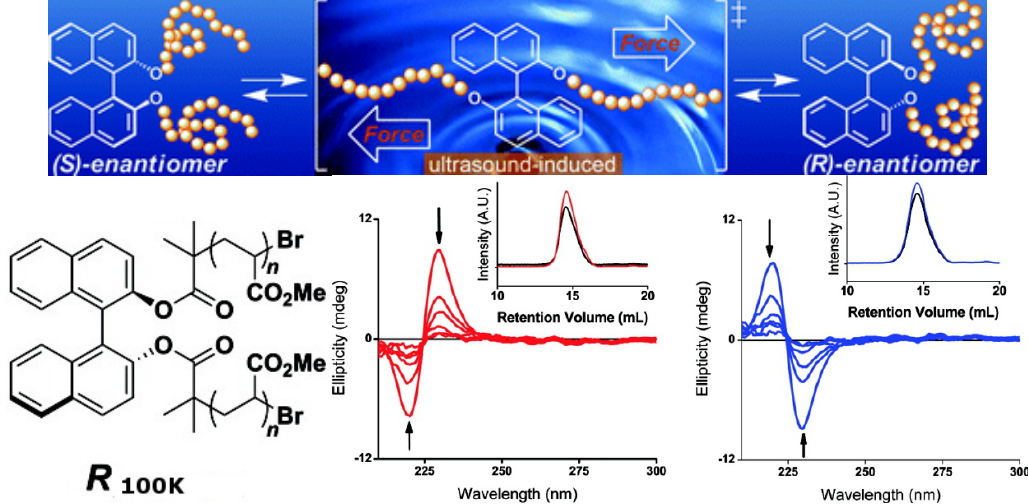
Figure 19. Top: Mechanically facilitated reconfiguration processes of R Bottom: CD spectra of CH functions of time under the sonication. The arrows indicate the direction of the spectra as they changed over time. The insets show gel-permeation chromatograms of S before (red and blue, respectively) and after sonication (black) [91]. Reproduced by permission of the American Chemical